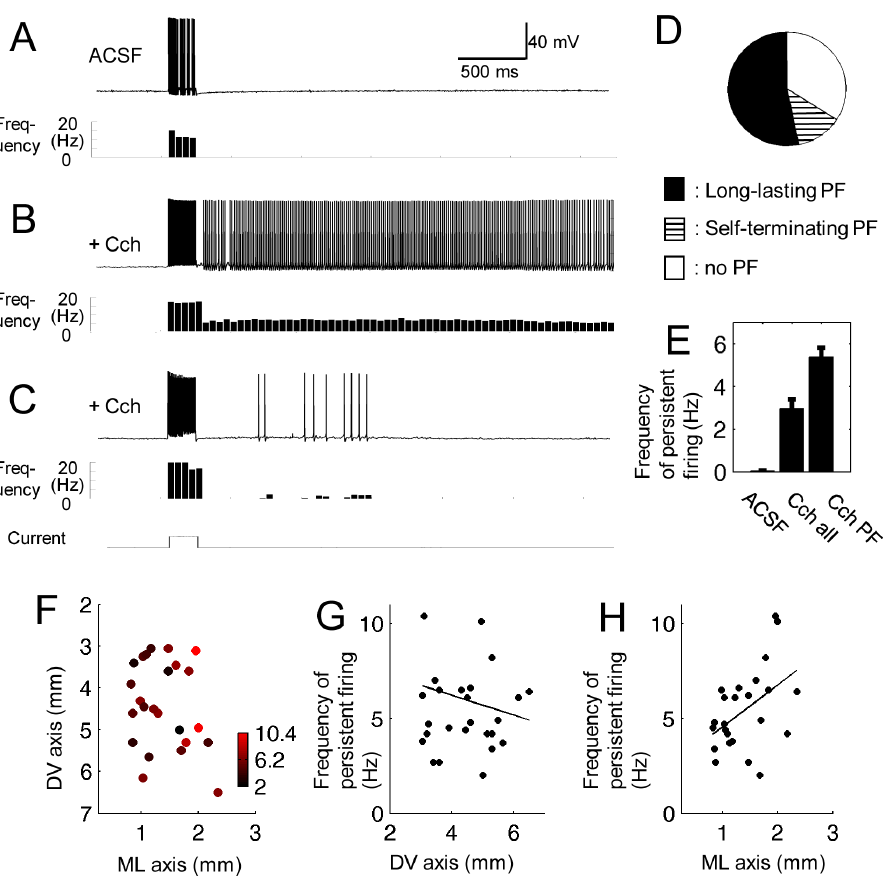
Figure 8. Persistent firing can be induced in cholinergic receptor agonist. (A) Response of an example cell to a 2 s current injection (100 pA) in normal ACSF. Histogram below shows firing frequency. (B) Response of the same cell to the same stimulation in carbachol (10 m M). Long-lasting persistent firing lasting for more than 30 s was elicited by the stimulation. (C) Example of self-terminating persistent firing ( , 30 s) in carbachol in a different cell. (D) Ratio of cells that showed long-lasting persistent firing, self-terminating persistent firing, and no persistent firing in carbachol. (E) Average frequency of persistent firing in normal ACSF and in carbachol. The bar graphs indicated by ‘‘Cch all’’ and ‘‘Cch PF’’ show average frequency of persistent firing in all cells and only in cells that showed long-lasting persistent firing, respectively. (F) Color plot of the frequency of persistent firing of cells that showed long-lasting persistent firing on the two-dimensional (DV and ML) anatomical space in carbachol. (G and H) Frequency of persistent firing of cells that showed persistent firing along the DV and ML axis, respectively, in carbachol. Cch: carbachol. PF: persistent